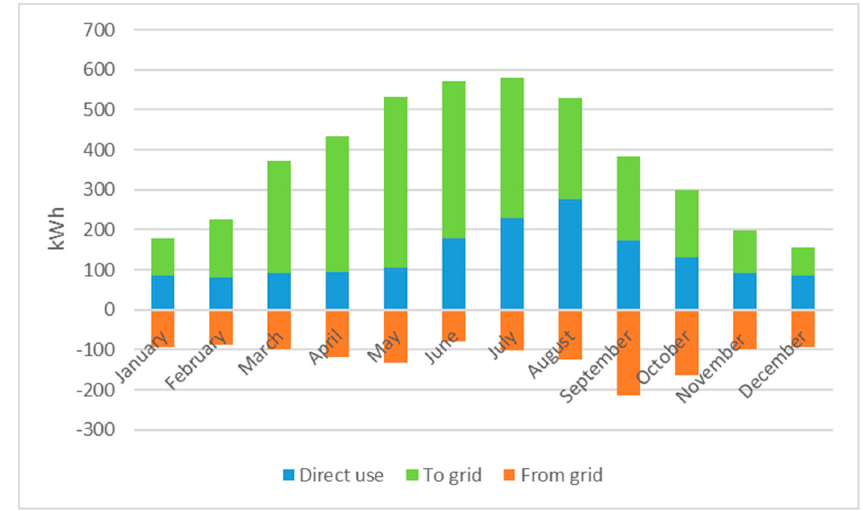
Figure 7. Monthly energy flows for the grid-connected PV configuration.